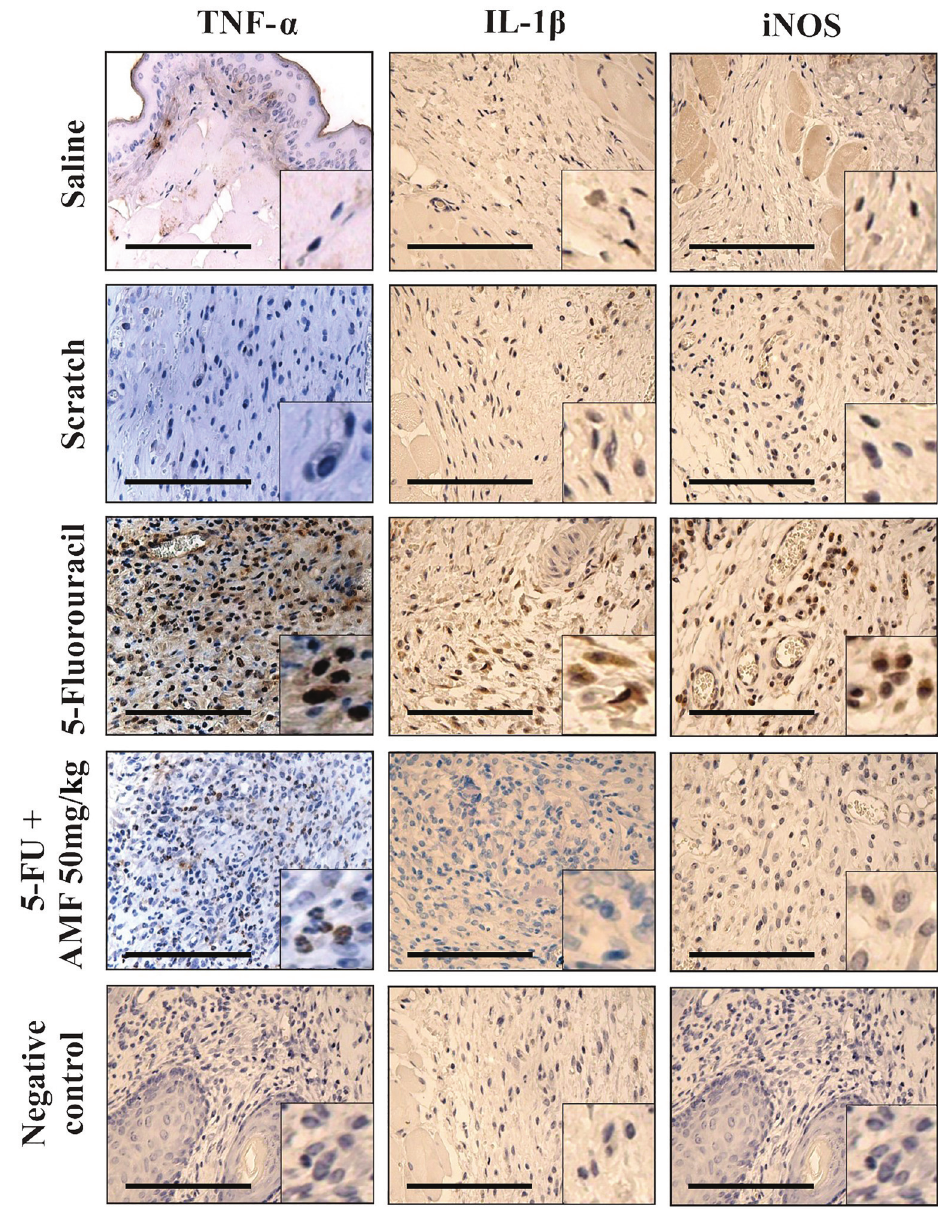
Figure 5. Amifostine (AMF) reduced tumor necrosis factor-alpha (TNF- a ), interleukin-1 beta (IL-1 b ), and inducible nitric oxide synthase (iNOS) immunostaining. Magni fi cation: 100 (cid:1) , scale bar: 250 m m. Representative stained cells are depicted in the lower right side of each panel (magni fi cation 400 (cid:1)